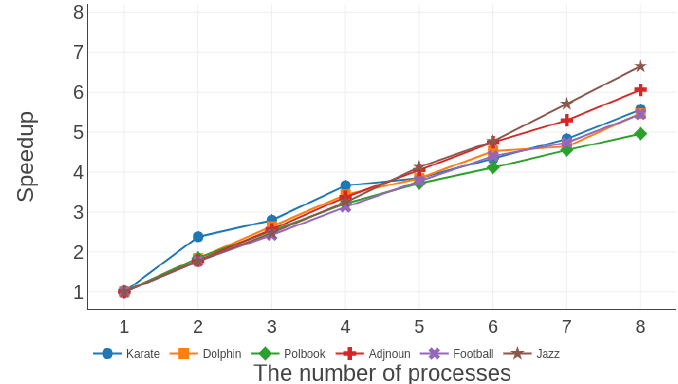
Figure 6. Speedup curves achieved by PCACD with the increase of the number of parallel processes for six real-world